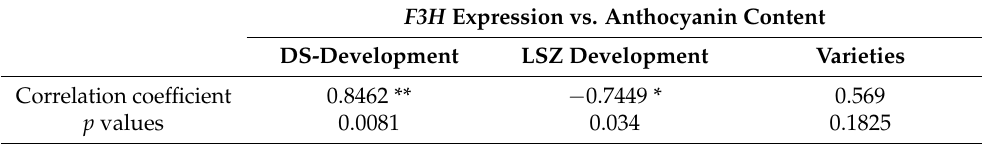
Table 1. Correlation of F3H expression level with anthocyanin content.